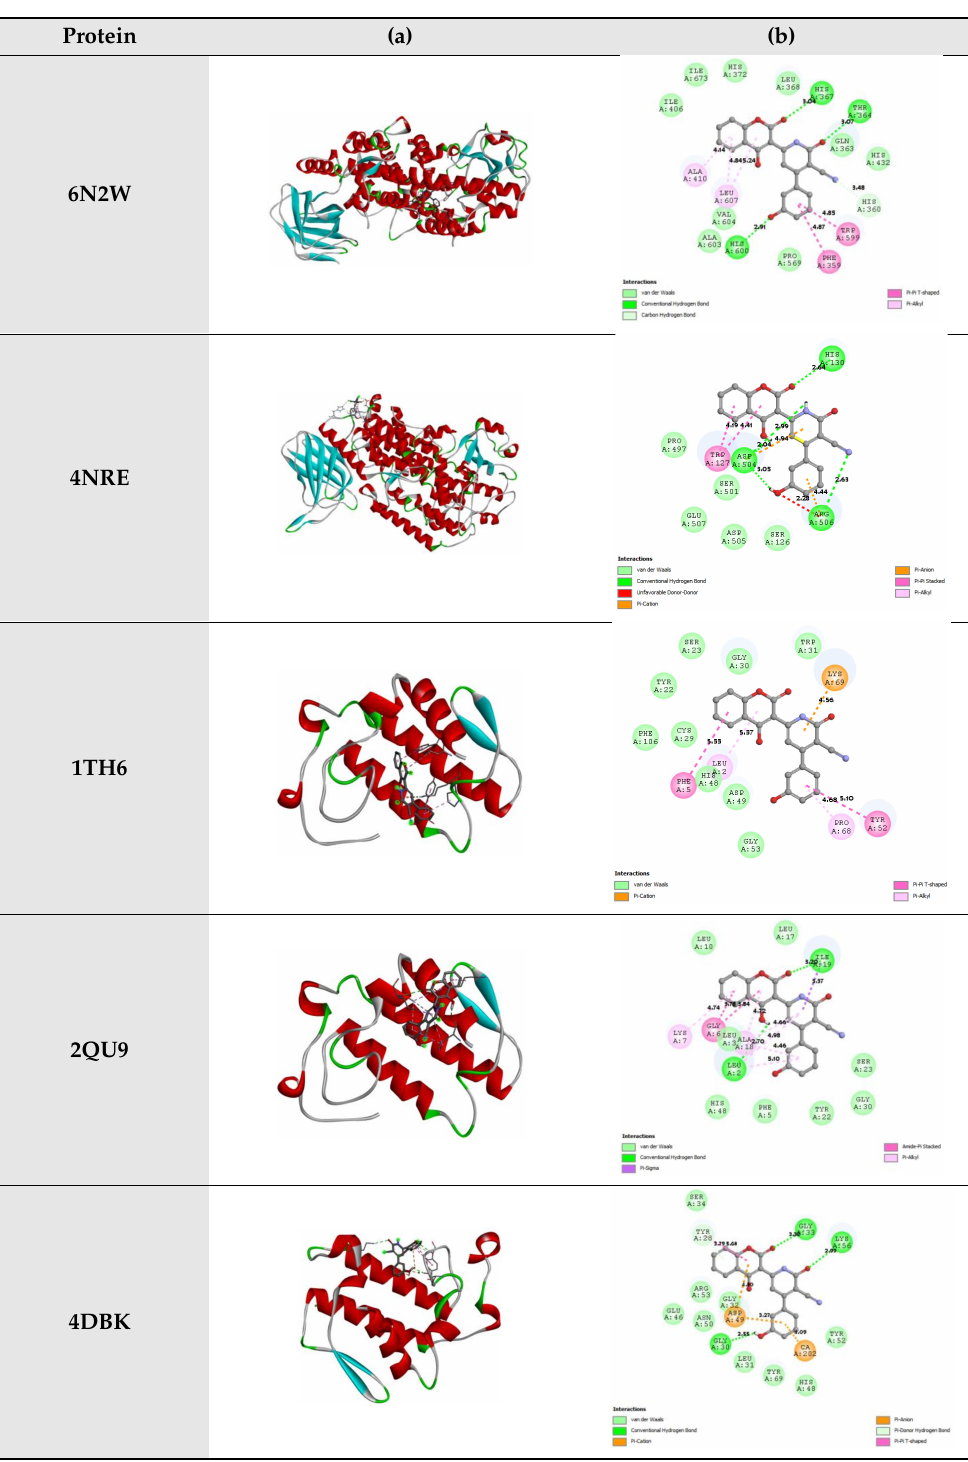
Table 15. Figures a and b: (a) best position of the coumarin4 inhibitor within the studied proteins; (b) 2D diagram of the interactions that occurred between the